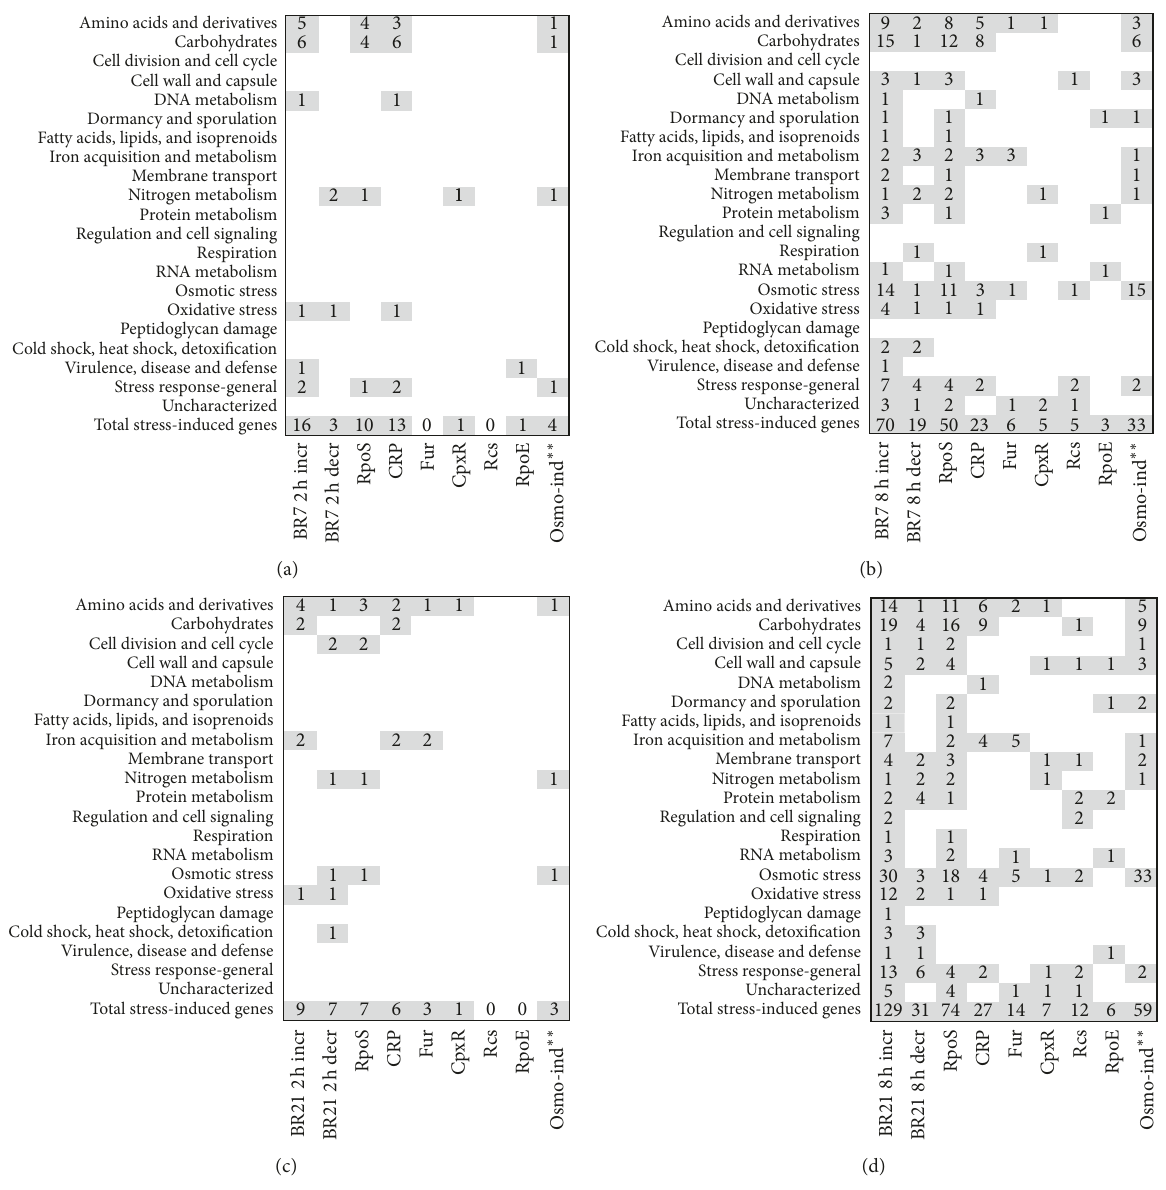
Figure 3: Transcriptional changes associated with strong osmotic and general RpoS stress response after lethal imipenem exposure . The panels indicate the number of genes (by ontological category) associated with stress-response regulons RpoS, CRP, Fur, CpxR, Rcs, and RpoE for BR7 2 h (a), 8h (b), BR21 2h (c), and BR21 8h (d). The first two columns in each panel indicate total stress-associated genes with increased (incr, column 1) or decreased (decr, column 2) expression (shown here with minimum threshold of 2-fold differential expression of imipenem-exposed compared to unexposed). Genes associated with stress regulons (in addition to those shown in Figure 1) were identified by RegulonDB, UniProt, and the experimental work of others. ∗∗ Genes associated with osmotic stress were identified through the experimental work cited here [31]. Table S4 presents the data by individual differentially expressed